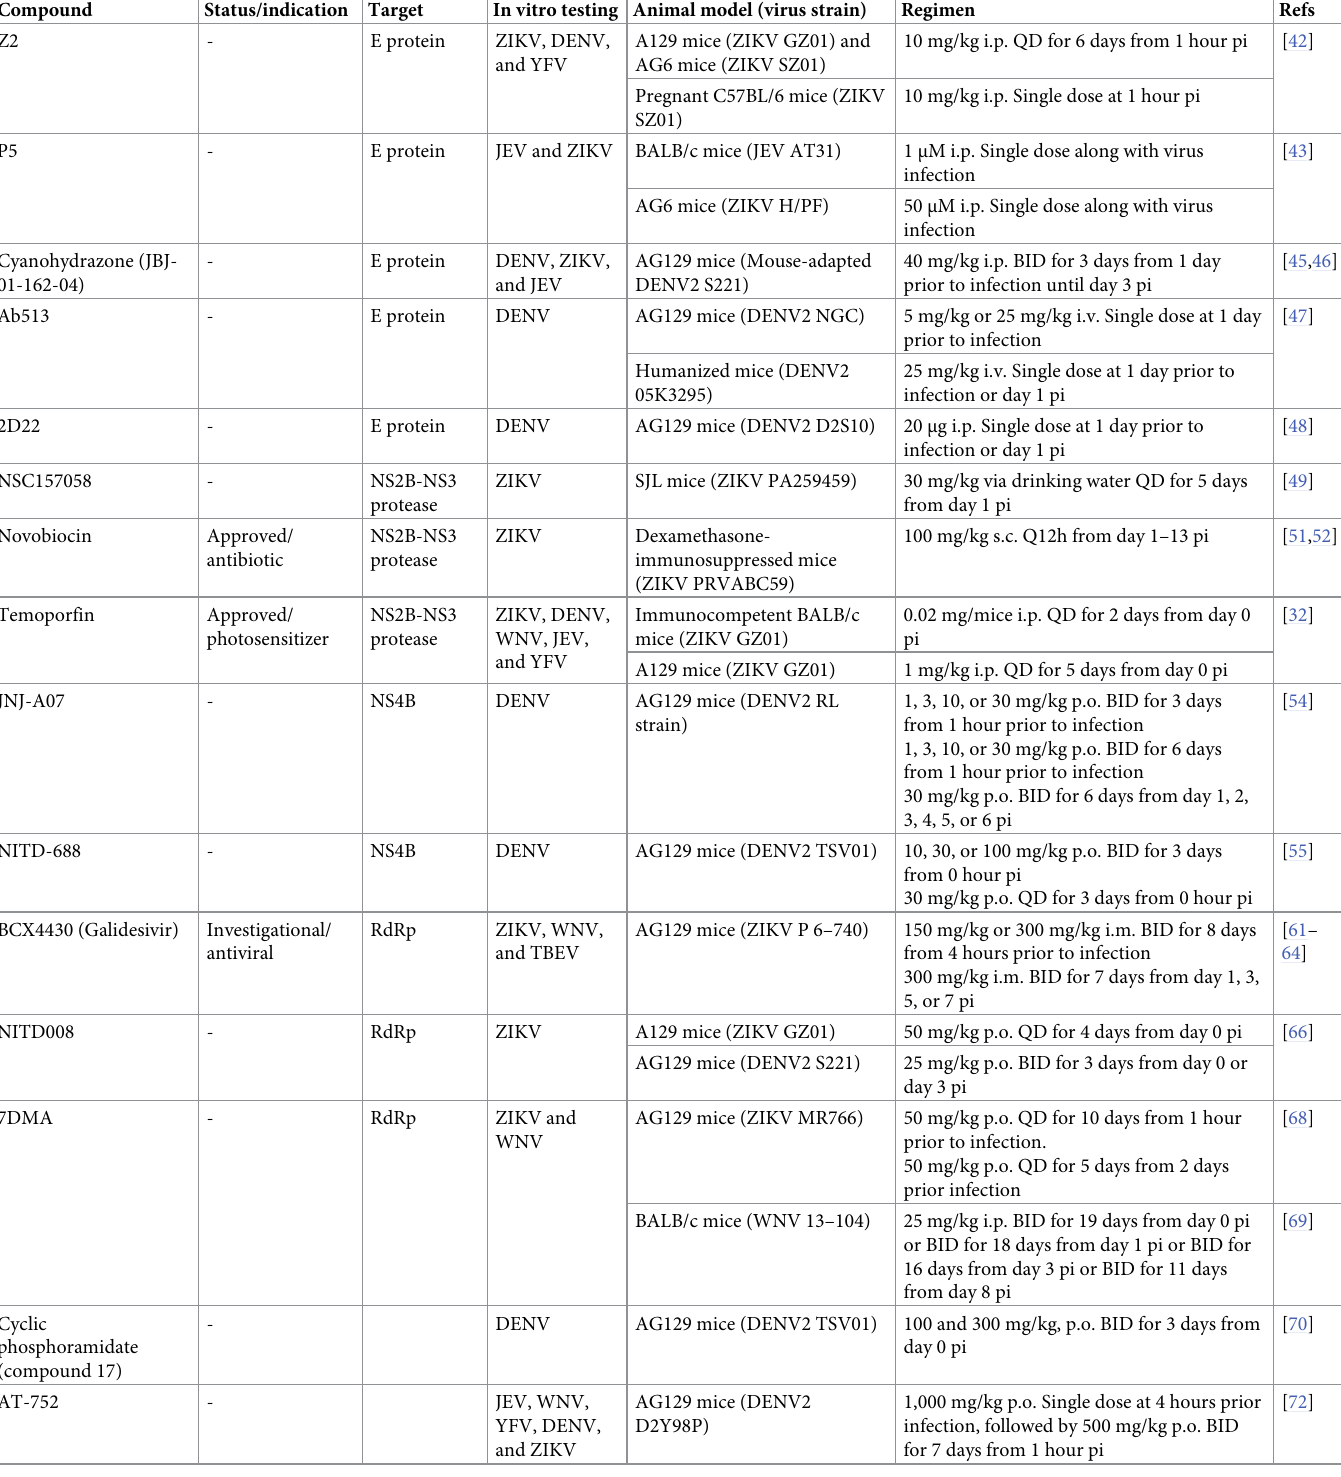
Table 1. Direct-acting antivirals for flaviviruses.